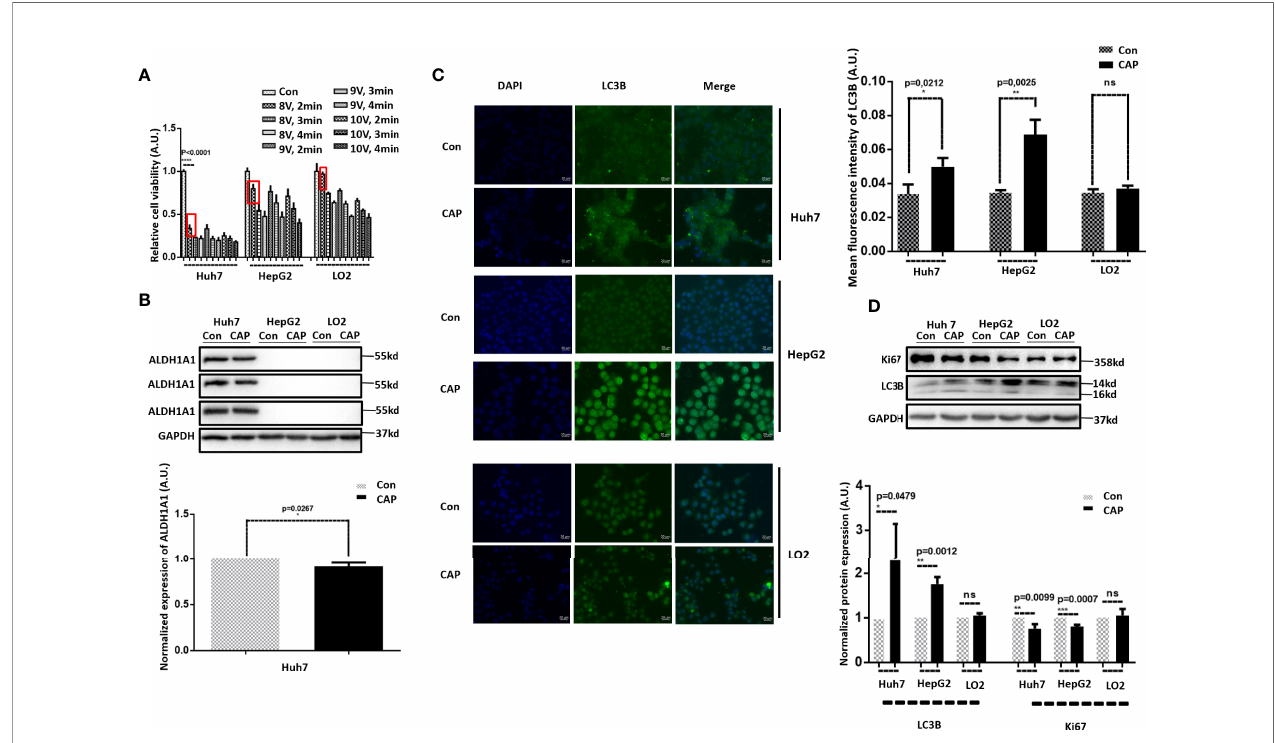
FIGURE 1 | CAP selectively induces autophagy in HCC cells. (A) Relative cell viabilities of Huh7, HepG2, and LO2 cells under different CAP treatment doses. (B) Western blots and quanti fi cations showing the expression of ALDH1A1 in Huh7, HepG2, and LO2 cells. (C) Western blots and quanti fi cations showing the expression of LC3B in Huh7, HepG2, and LO2 cells with and without CAP treatment. (D) Immuno fl uorescence imaging and quanti fi cations showing the level and location of LC3B in Huh7, HepG2, and LO2 cells with and without CAP treatment. 97L and 97H each represents MHCC97L and MHCC97H. Quanti fi cations were made from triplicates. *, **, ***: statistical signi fi cance. ns: there is no statistical signi fi